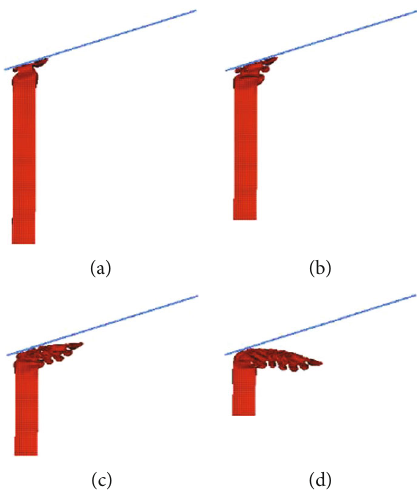
Figure 32: The deformation history of designed tube with circumferential constraints.